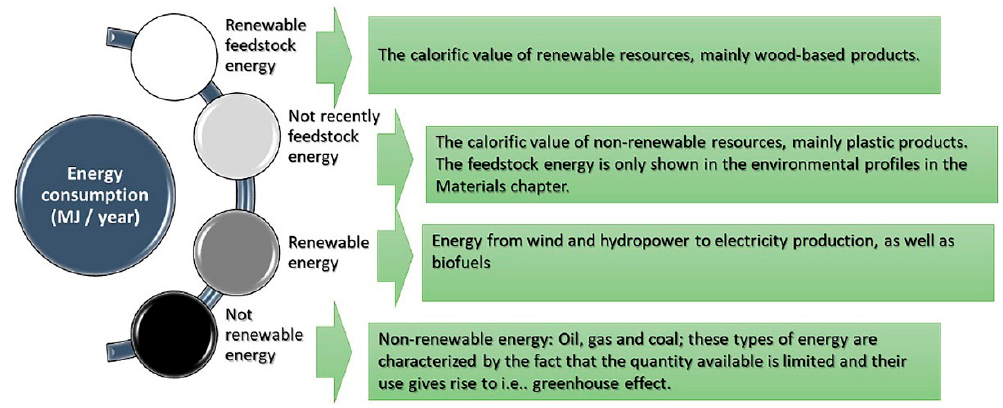
Figure 5. The environmental indicators show the environmental impact of resource consumption. The environmental consequences of resource use may include a lack of energy, an increased area consumed, and risks associated with the extraction or cultivation process. The results of applying this indicator to the five chosen wooden façade materials are seen in the diagram below (see Figure 6).